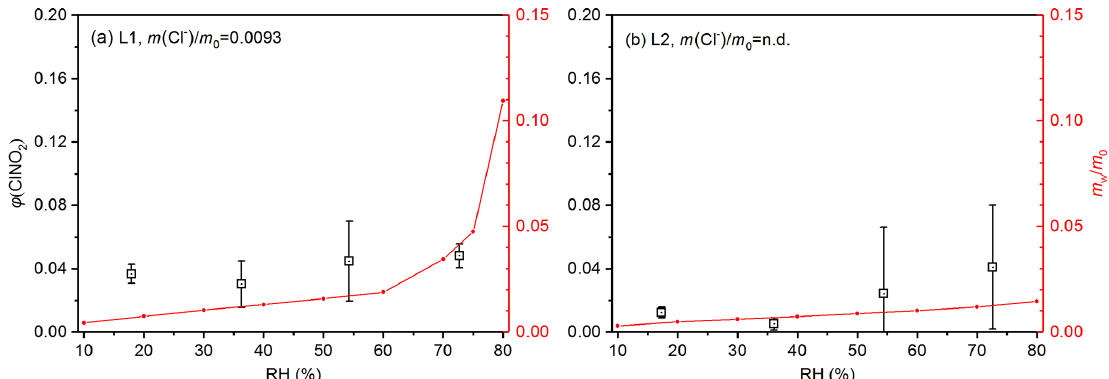
Figure 4. Measured ClNO 2 yields (black symbol) and m w /m 0 (red line) as a function of RH for (a) L1 and (b) L2. The error bar represents standard deviation, and m w /m 0 represents the normalized mass of particulate water (normalized to the mass of dry particles), which was measured as the relative increase in particle mass at a given RH compared to < 1% RH.